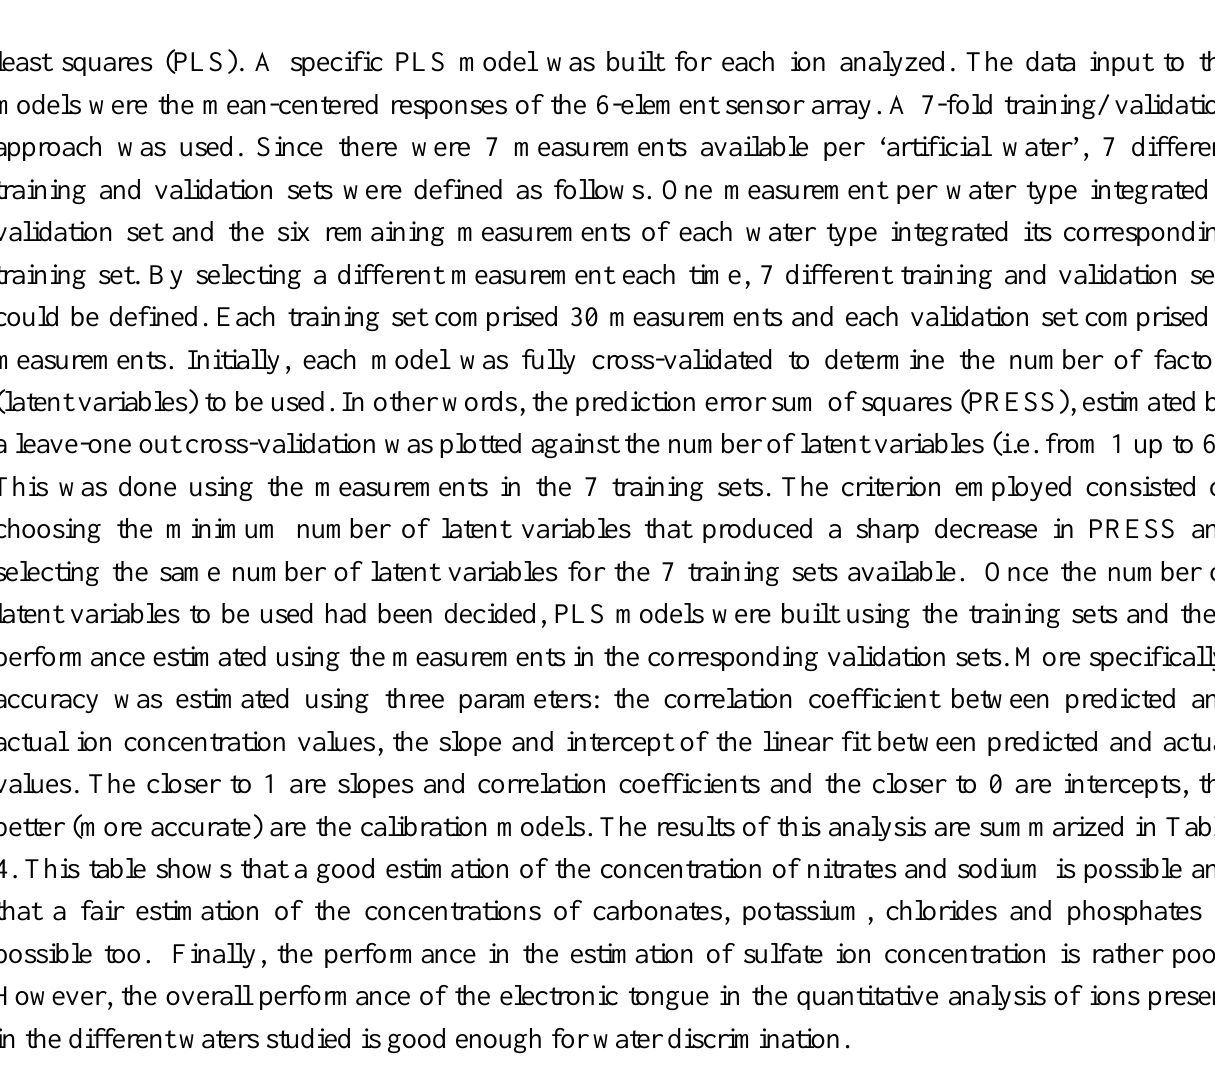
Table 4 .Cross-validation results of the calibration models built to predict the concentration of ions within the dissolutions studied (intercept is in